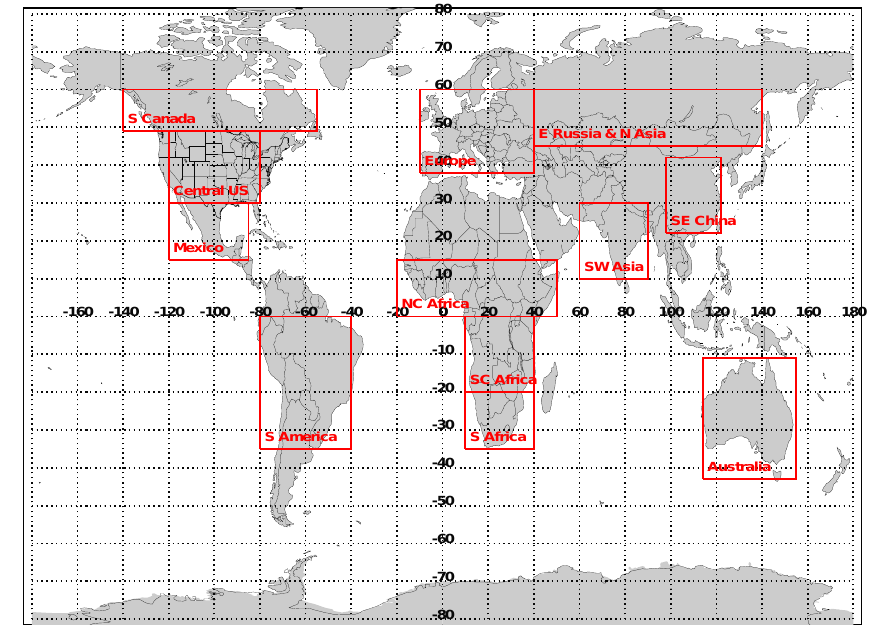
Fig. 14. Delimitation regions of interest that are grouped together for regional analysis. weather maximum, rather than the sharp July peak predicted by GEOS-Chem. Over southeast China measurements and model estimates also show a peak in the warmer